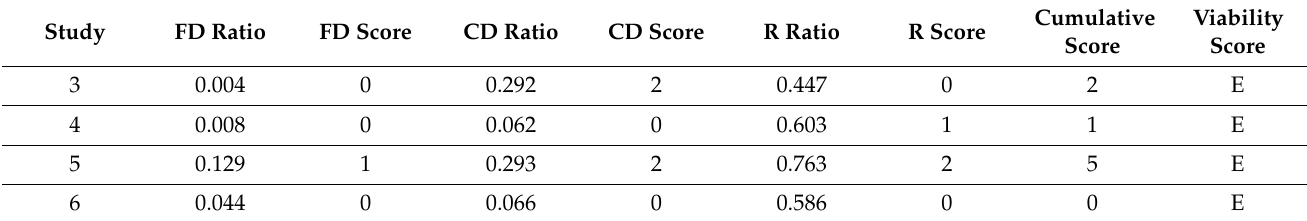
Table 3. Median bacterial density normalized relative to the initial bacterial density (D0